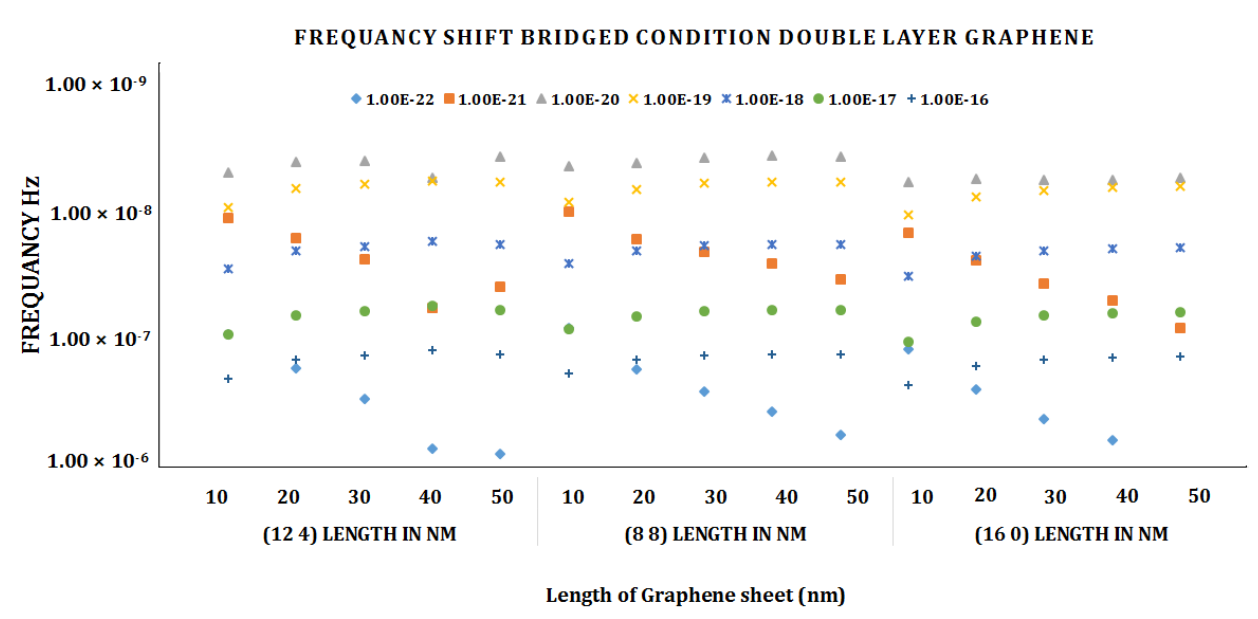
Figure 9. Frequency shift vs. different lengths of graphene sheet (nm) graph for chiral, armchair, and zigzag bridged DLG.